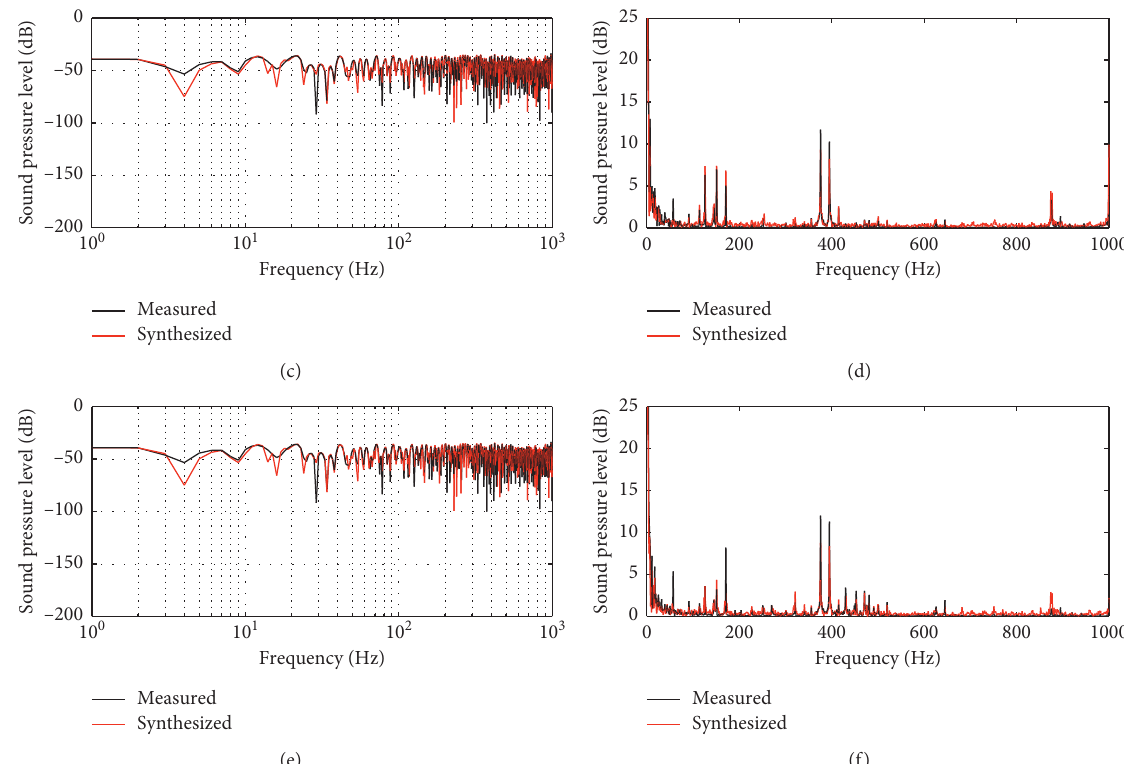
Figure 30: Response synthesis for measurement 2: (a) d � 240mm; (b) d � 240mm; (c) d � 750mm; (d) d � 750mm; (e) d � 1260mm; (f) d � 1260mm.